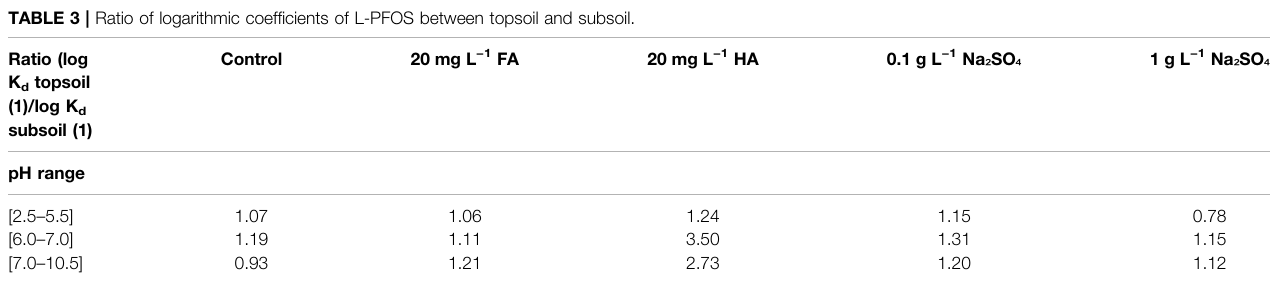
TABLE 3 | Ratio of logarithmic coef fi cients of L-PFOS between topsoil and subsoil. Ratio (log K d